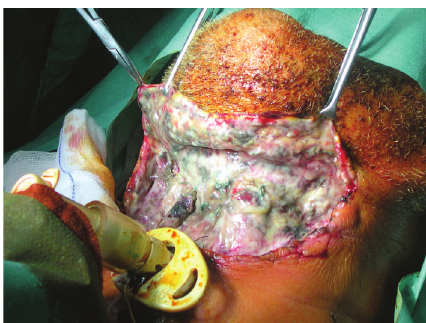
Figure 4: Patient number 2—surgical images. All the neck tissues appear necrotic and di ffi cult to distinguish. Right septic throm- bophlebitis of the internal jugular vein (Lemierre’s syndrome) can be